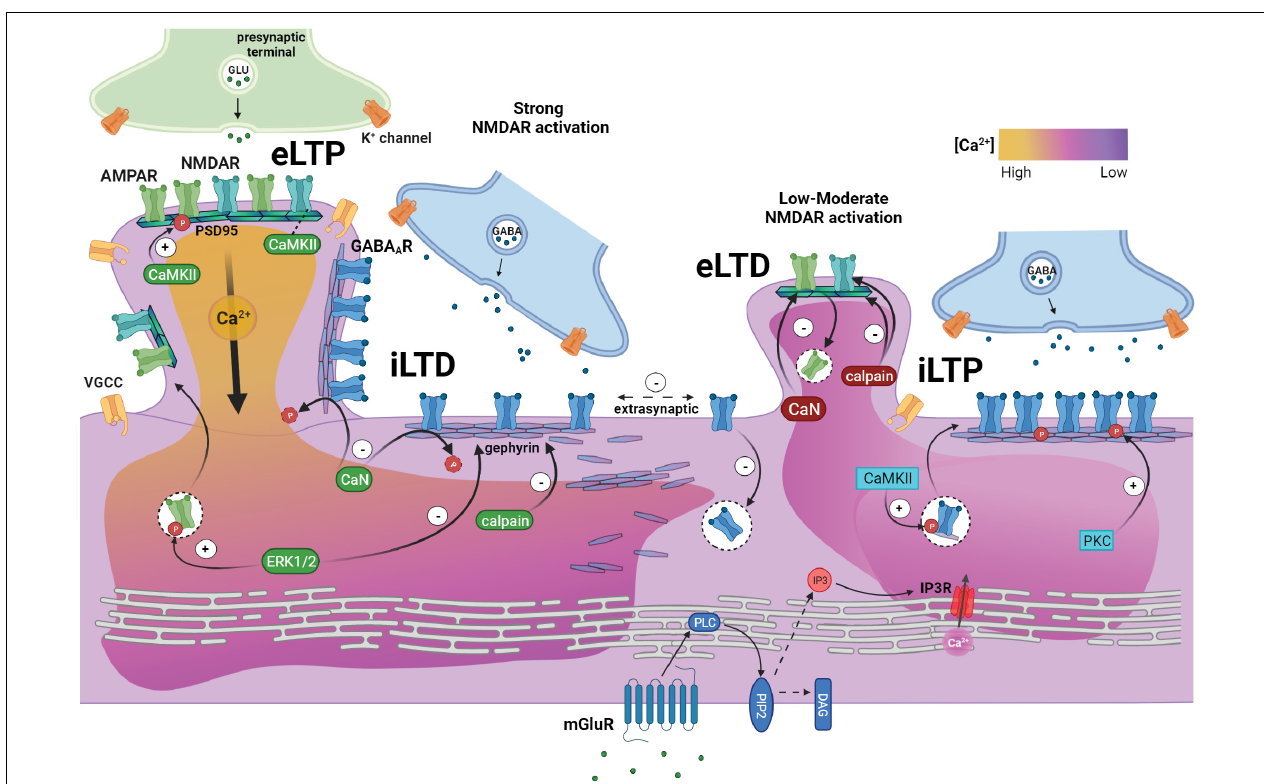
FIGURE 1 | Relative local calcium levels facilitate glutamatergic and GABAergic synaptic crosstalk and plasticity responses through an intersection of downstream signaling pathways. Left: Strong glutamatergic activation and high calcium influx (yellow) triggers excitatory long-term potentiation (eLTP) associated with ERK1/2-mediated insertion of synaptic AMPARs, which is facilitated by translocation of CaMKII α to excitatory synapses and interaction with NMDARs. CaMKII α phosphorylation additionally stabilizes synaptic AMPARs. eLTP also induces heterosynaptic long-term depression of nearby inhibitory synapses (iLTD). During iLTD, calcineurin-mediated dephosphorylation of γ 2-GABA A Rs increases receptor mobility and diffusion to extrasynaptic sites, while ERK1/2-mediated gephyrin phosphorylation and calpain protease activity disassembles the gephyrin scaffold. Right: During low-moderate NMDAR activation, CaMKII α translocation to inhibitory synapses facilitates inhibitory long-term potentiation (iLTP) through synaptic gephyrin recruitment and enhanced β 3-GABA A R forward trafficking and membrane insertion. Simultaneously, moderate NMDAR stimulation triggers a calcineurin-mediated reduction in surface AMPARs and calpain proteolytic degradation of NMDAR-GluN2B subunit and glutamatergic PSD95 scaffold (excitatory long-term depression, eLTD). eLTD and spine shrinkage is also observed in response to eLTP of proximal spines, while iLTP occurs at synapses distant from the potentiating spine. Bottom: Activation of group I metabotropic mGluR induces downstream IP3 receptor activation and release of calcium stores from the endoplasmic reticulum. The moderate increase in calcium concentration (pink) prompts PKC-mediated GABA A R phosphorylation and stabilization, contributing to the strengthening of inhibitory synapses during iLTP. Created with